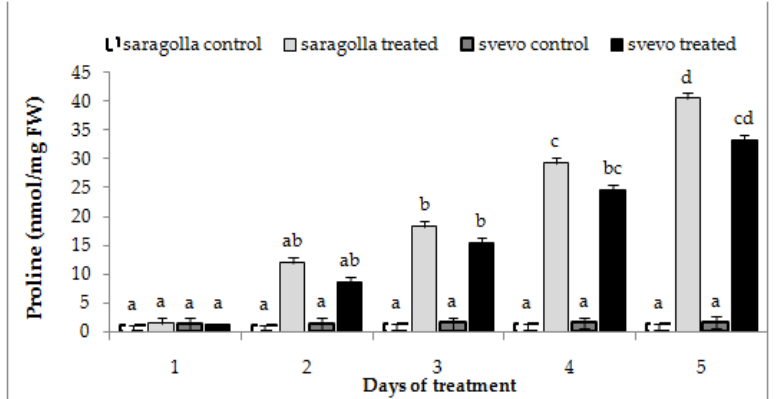
Figure 6. Proline accumulation in Saragolla and Svevo roots subjected to osmotic stress. Seven days-old Saragolla and Svevo seedlings were subjected to osmotic stress for 5 days, by means of 18% PEG-6000 administration, and after 2 and 5 days the proline concentration in roots of control and stressed samples was measured by the acid ninhydrin method, as reported in Section 4.6, and values compared to those of control, unstressed seedlings. Results from three independent experiments are reported; values are expressed as the mean ± SD. Statistical significance was attributed by one-way ANOVA test. Bars labeled with dissimilar letters are significantly different ( p < 0.05).